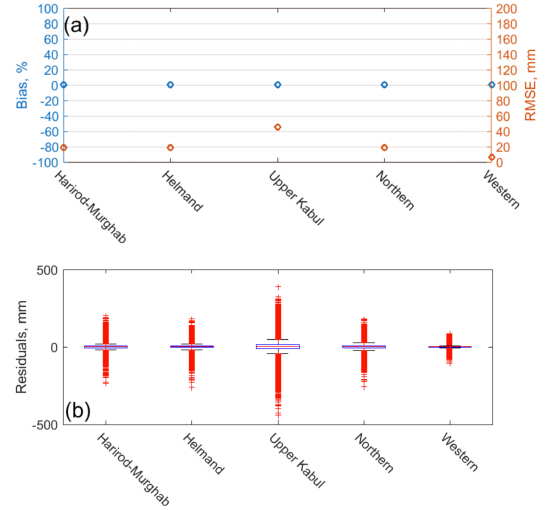
Figure 9. Same as Fig. 8, except by basin for all years, (a) Bagged trees bias and RMSE; and (b)